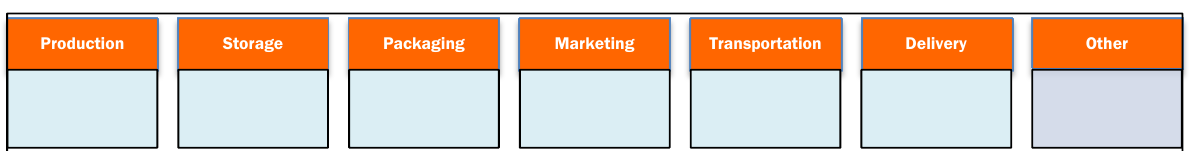
Figure 1. Proposed Value Chain